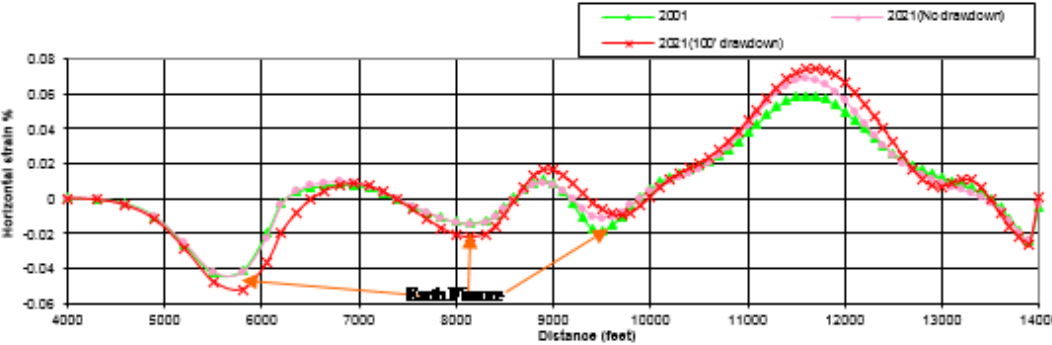
Figure 3. Prediction of horizontal strain and location of potential earth fissure zone along the McMicken Dam.